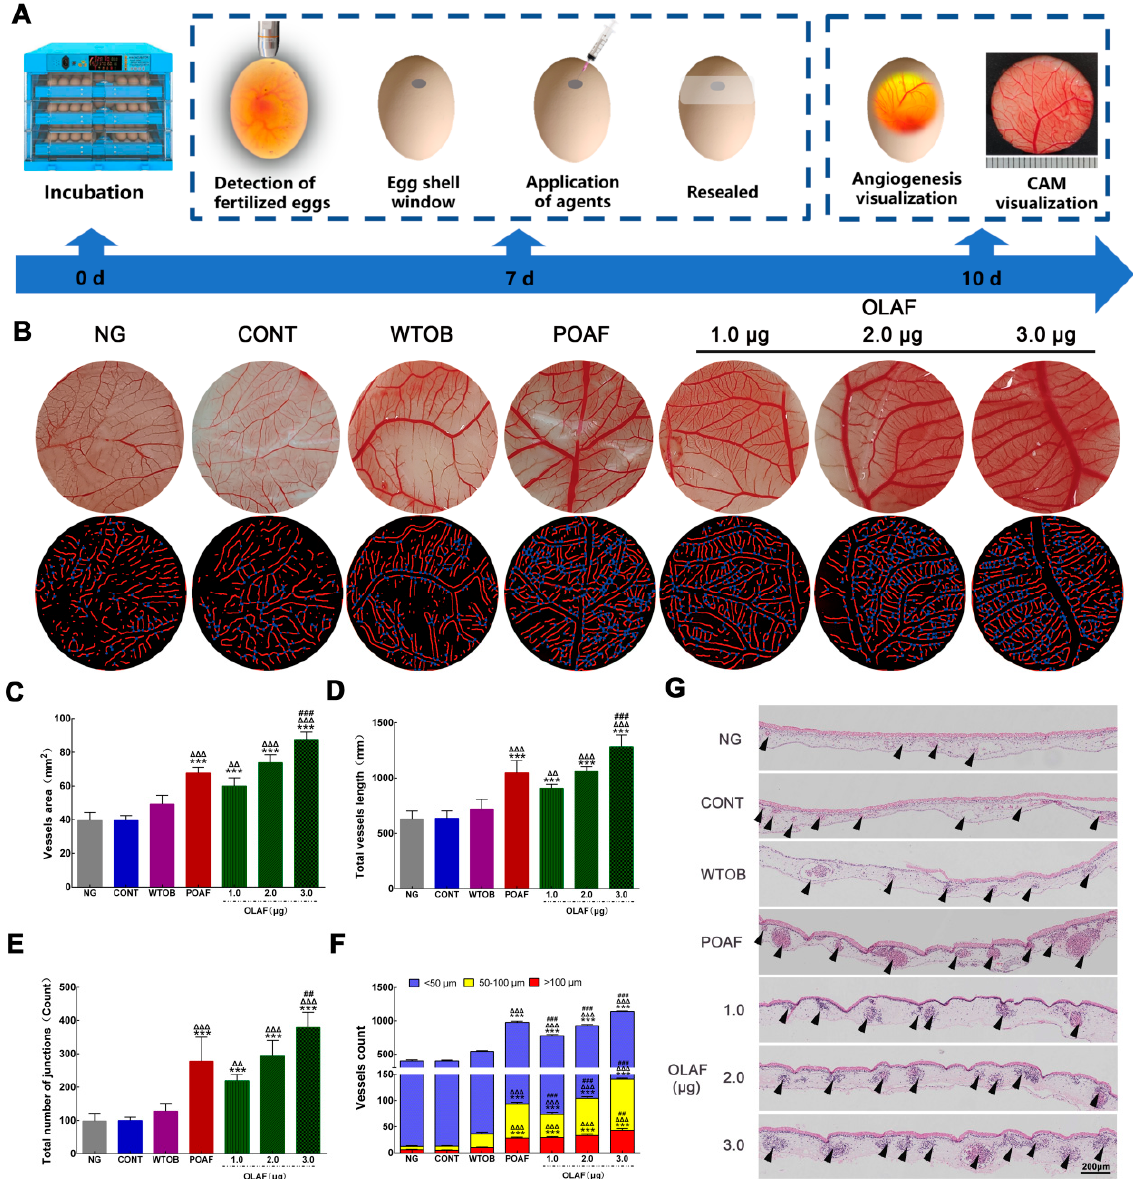
Figure 4. Oleosomes fused with human fibroblast growth factor 1 (OLAF) accelerated angiogenesis in the chick embryo choriollantoic membrane (CAM). ( A ) A schematic illustration of the chick embryo choriollantoic membrane assay used to investigate the angiogenesis induced by OLAF. ( B ) Appearance observation (first row) and simulation diagram of the blood vessels (second row) of the chicken embryo allantoic membrane in seven groups, where the red lines and blue dots are used to indicate the blood vessels and junctions, respectively. ( C – F ) Statistical charts of the vessel area, total vessel length and the number of vessel junctions and blood vessels with different diameters in the chorioallantoic membrane of the chicken embryo. ( G ) Histological morphology of the chicken chorioallantoic membrane was observed to assess the differences in the blood vessels between various groups, which are marked by black arrows. The mean ± SD was employed to display all the obtained data (n = 6). *** p < 0.001 vs. CONT group; ΔΔ p < 0.01, ΔΔΔ p < 0.001 vs. WTOB group; ## p < 0. 01, ### p < 0.001 vs. POAF group.